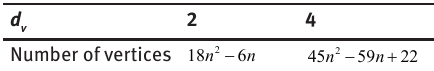
Figure 23: Plot of A D Table 6: The vertex partition of D